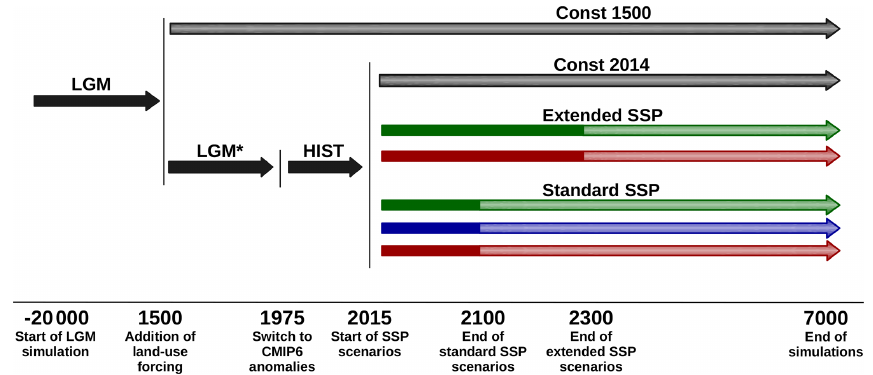
Figure 1. Diagram of the simulation setup. A transient simulation from the LGM to 1975 and with additional land-use forcing after 1500 (LGM ∗ ) is followed by short historical simulations until 2014 (HIST) and subsequent standard and extended Shared Socioeconomic Pathway (SSP) scenario simulations forced by CMIP6 climate anomalies. After the end of the transient forcing (solid arrows), SSP scenarios are continued with constant forcing (light color arrows). Additional commitment simulations with constant boundary conditions start at 1500 and